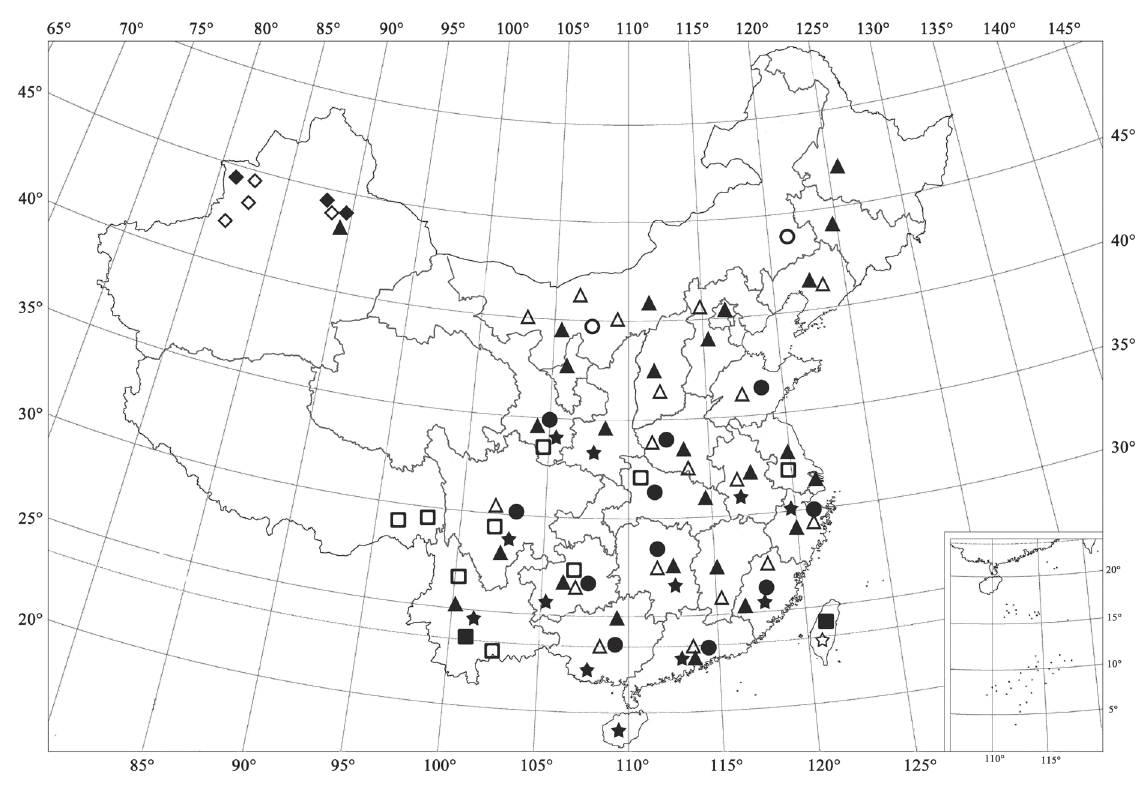
Fig. 22. Distribution map. ( ) = Chilocorus chalybeatus Gorham, 1892; ( ) = C. shirozui Sasaji, 1968; (●) = C. hupehanus Miyatake, 1970; (○) = C. strenotubus Li & Wang sp. nov.; (▲) = C. kuwanae Silvestri, 1909; ( ) = C. esakii Kamiya, 1959; (■) = C. alishanus Sasaji, 1968; (□) = C. bijugus Mulsant, 1853; ( ) = C. bipustulatus (Linnaeus, 1758); ( ) = C. geminus Zaslavskij,